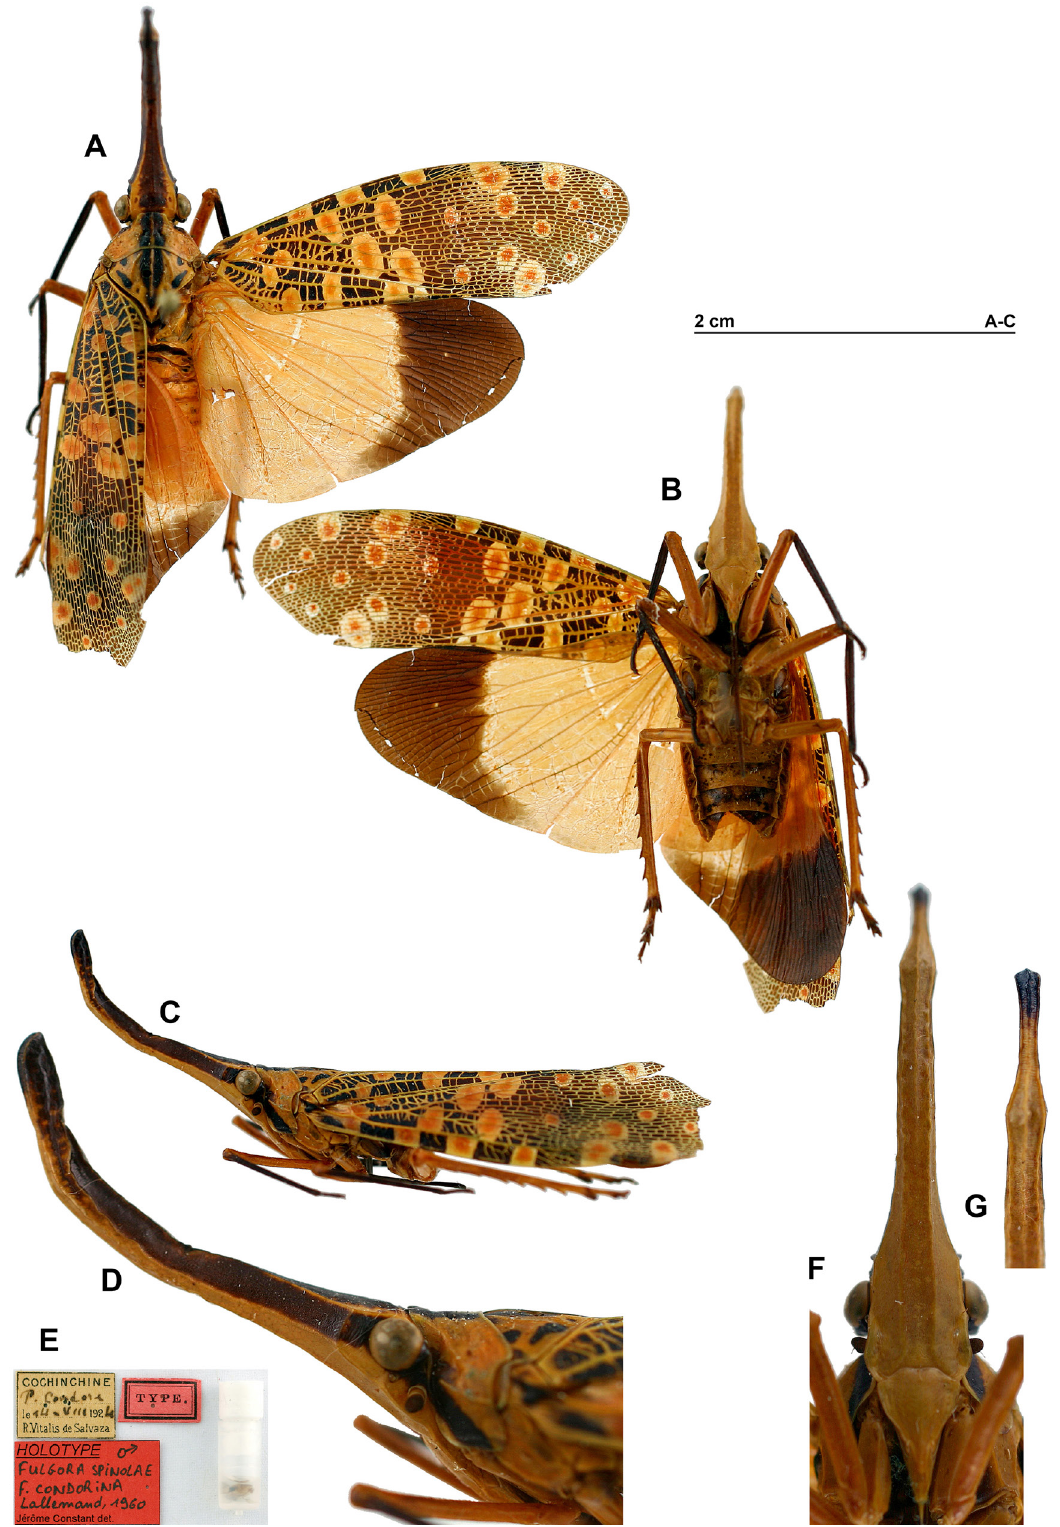
Fig. 4. Pyrops condorinus (Lallemand, 1960), holotype ♂ (FSAG). A . Habitus, dorsal view. B . Habitus, ventral view. C . Habitus, lateral view. D . Head and thorax, lateral view. E . Labels and genitalia tube. F . Head, perpendicular view of frons. G . Apex of cephalic process, anteroventral view. D–G = not to